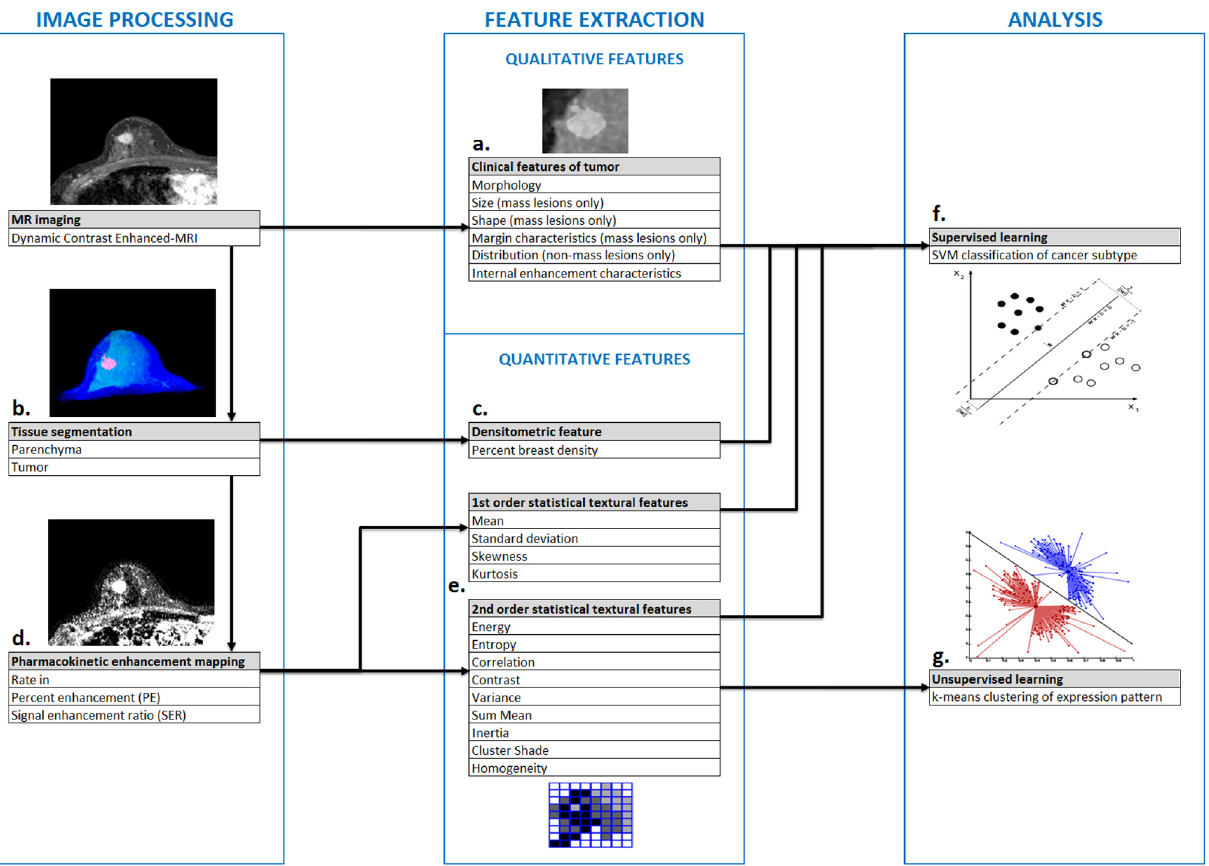
Fig 2. Summary of radiomic analysis performed in this study. Clinical features were evaluated by a radiologist according to Breast Imaging Reporting and Data System directly from dynamic contrast-enhanced MRI (a). 3-Dimensional tumor (red) and parenchyma (light blue) compartments were segmented (b), from which volumetric breast density was immediately estimated (c). Enhancement maps were then generated (d), from which textural features of tissue compartments were extracted and defined as enhancement heterogeneity (e). Subsequently, two analyses were conducted using extracted features: supervised learning of breast cancer subtype was performed with a support vector machine classifier (f) and unsupervised learning of background parenchymal enhancement feature expression pattern was performed with k -means clustering